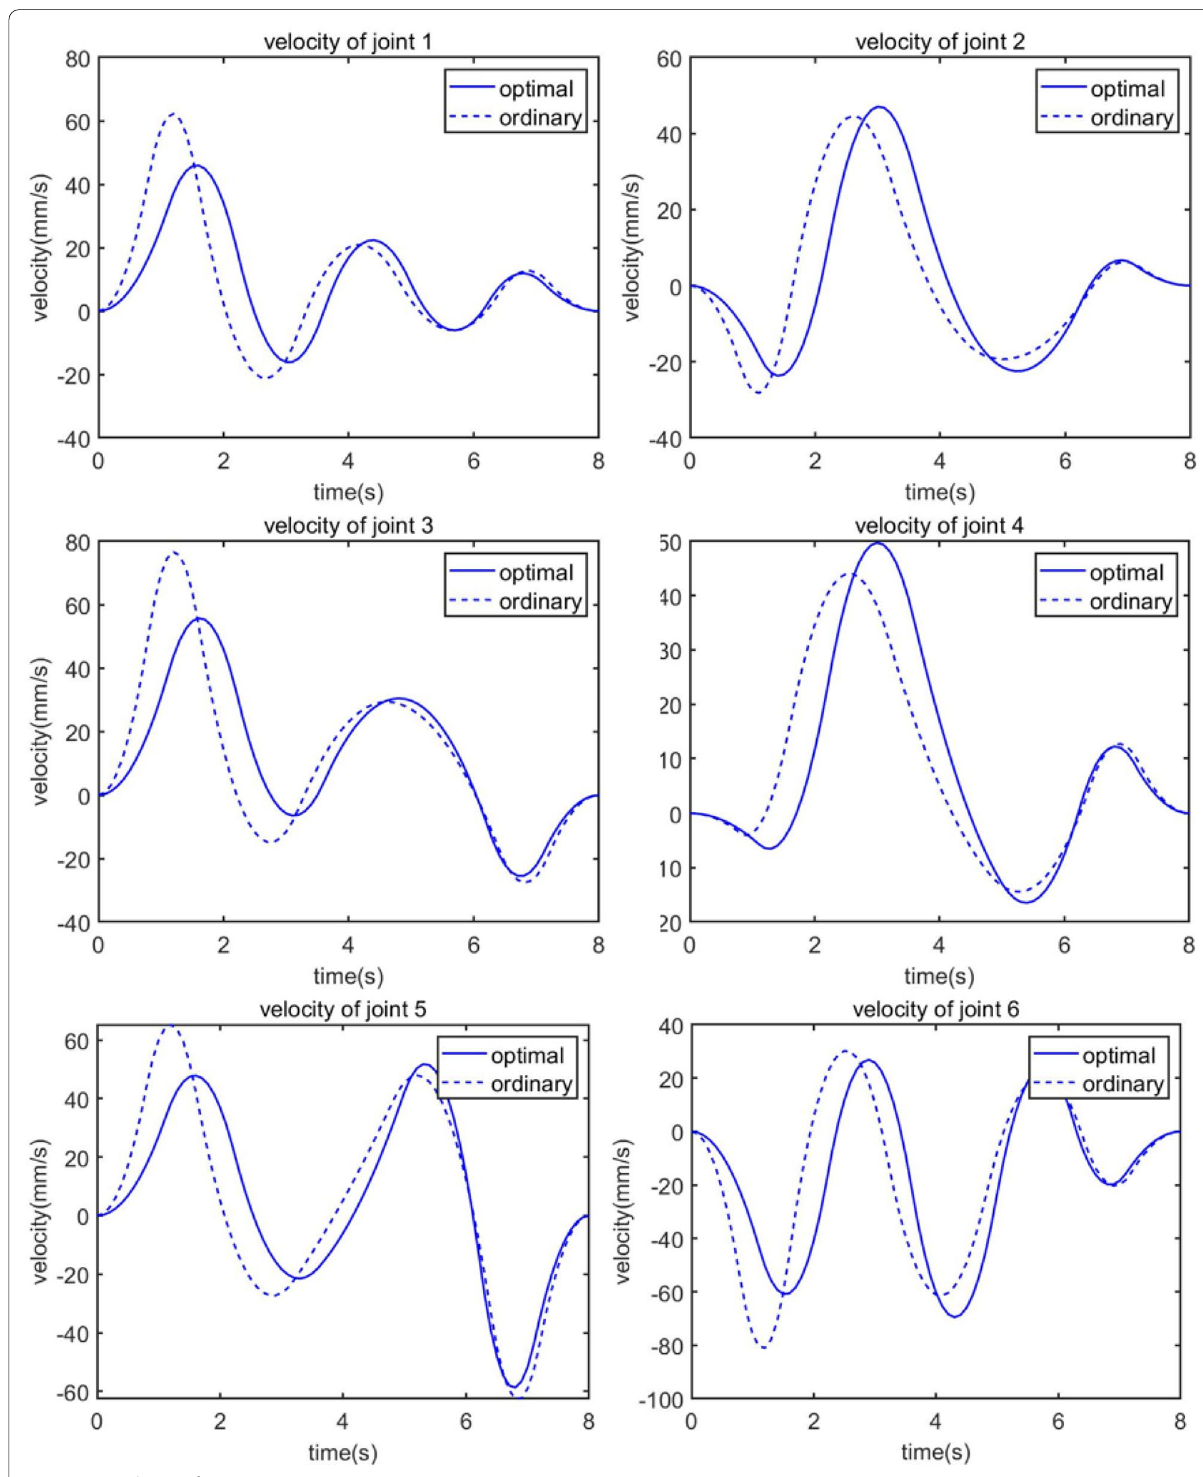
Figure 11 Velocity of